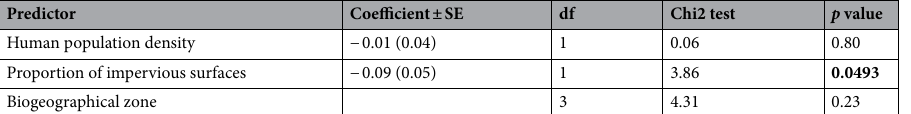
Table 1. Results from the species-urbanization spaMM model. p values in bold are significant (α = 5%). Coefficients for continuous variables are from the summary of the model and are given with their standard error. The p value and the chi square tests were evaluated using Likelihood Ratio Tests between the full model and the full model without the considered variable.